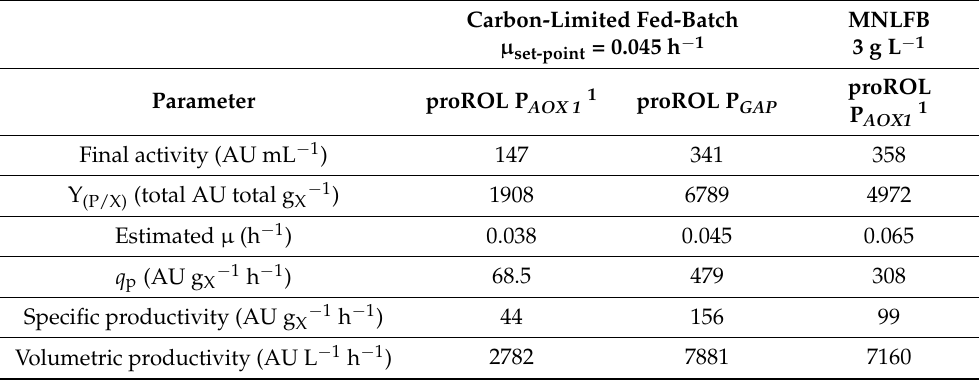
Table 2. Results obtained with proROL P GAP -strain under carbon-limited fed-batch conditions, and also with proROL P AOX1 -strain under either methanol-limited fed-batch (MLFB) conditions at a preset specific growth rate of 0.045 h − 1 or methanol non-limited fed-batch (MNLFB) conditions at a constant methanol concentration of 3 g L − 1